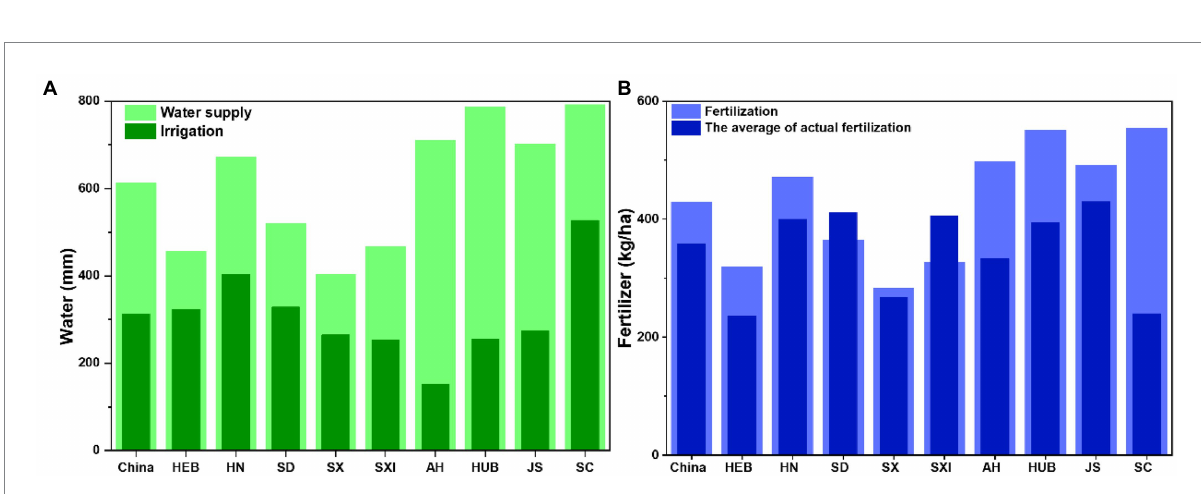
FIGURE 7 The adaptation of winter wheat production to temperature during 1996 to 2017. (A) Adaptation demand of water supply and irrigation. (B) Adaptation demand of fertilization and its actual